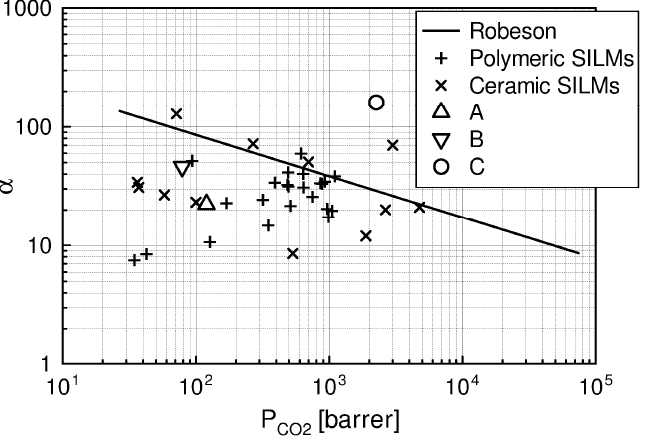
Figure 10. Separation performance comparison for investigated SILMs and literature data: A—Membrane A impregnated with [Emim][Ac], B—Membrane B impregnated with [Emim][BF 4 ], C—Membrane C (PDMS) impregnated with [Emim][Ac]. Table 3. Comparison of process parameters for the investigated methods of CO 2 removal at 40 °C and atmospheric pressure. Investigated Meth- ods with